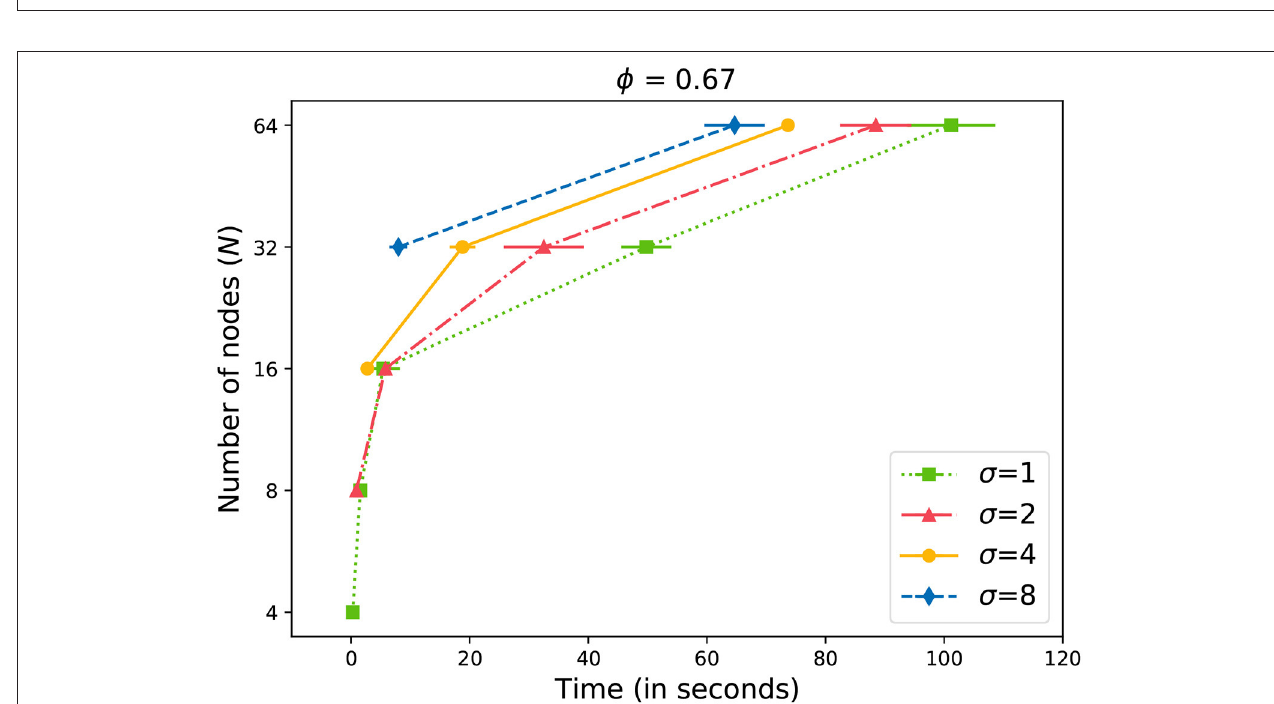
FIGURE 5 | Time to gossip a message with φ = 0.67.